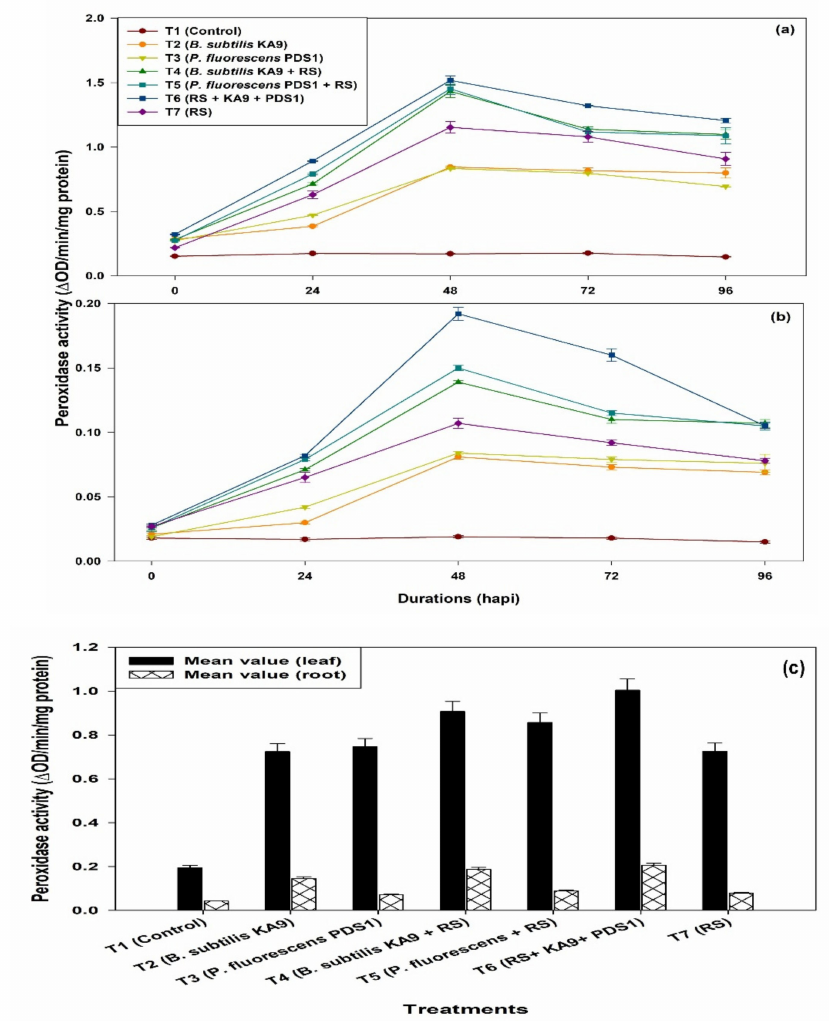
Figure 10. ( a ) The effect of biocontrol agents on the induction of Peroxidase activities in chilli leaves against R. solanacearum in glasshouse conditions; observations were recorded after 30 days of sowing. ( b ) The effect of biocontrol agents on the induction of peroxidase activities in chilli roots against R. solanacearum in glasshouse conditions; observations were recorded after 30 days of sowing. The results are expressed as average of three replications and error bars indicate standard deviation of the means. ( c ) Mean value comparison of the induction of Peroxidase (PO) activity in between chilli leaves and root against Ralstonia solanacearum in glasshouse condition after 30 days of sowing. The results are expressed as average of three replications and error bars indicate standard deviation of the